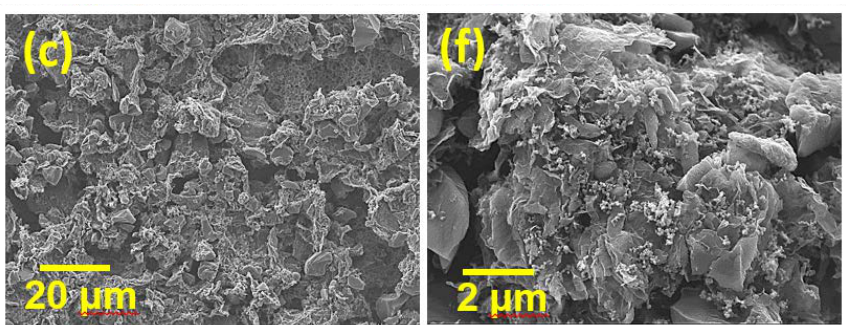
Figure 4. Low-magnification SEM images of ( a ) AC / HGNS-900 (20:1); ( b ) AC / HGNS-900 (10:1); and ( c ) AC / HGNS-900 (5:1) electrodes. High-magnification SEM images of ( d ) AC / HGNS-900 (20:1); ( e ) AC / HGNS-900 (10:1); and ( f ) AC / HGNS-900 (5:1) electrodes.